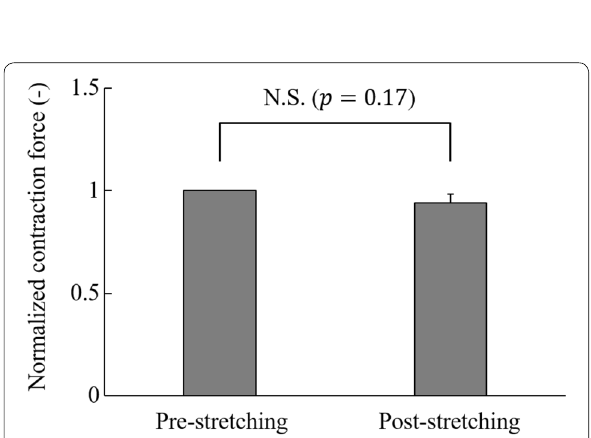
Fig. 5 Maximum voluntary contraction (MVC). Means and standard errors of 16